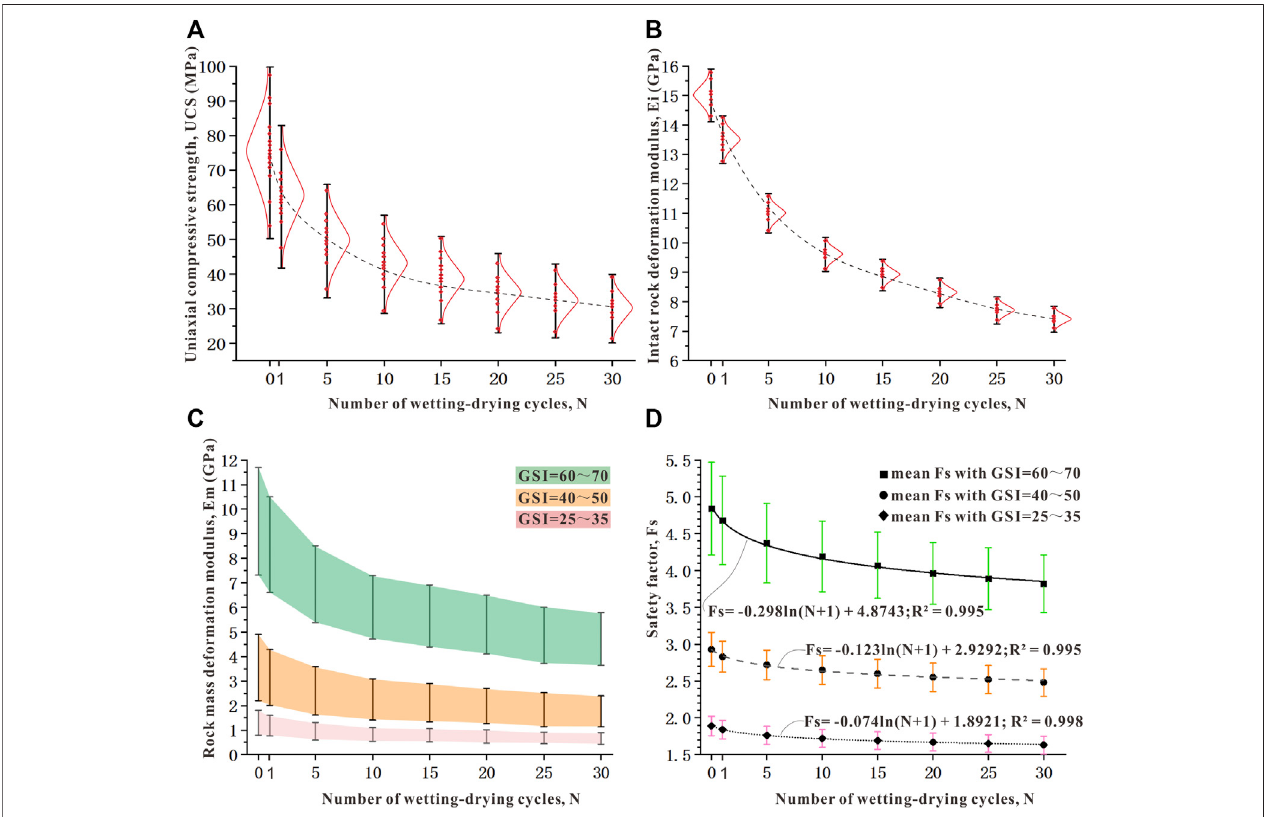
FIGURE2|(A) Uniaxialcompressivestrengthrangeand (B) deformationmodulusrangeofintactsandstoneexposedto1,5,10,15,20,25,and30wetting – drying cyclesincorporatingnormaldistribution. (C) Rockmassdeformationmoduluschangingtrendatdifferentstagesofwetting – dryingcycling. (D) Relationshipsbetweenthe number of wetting – drying cycles and the safety factor of the